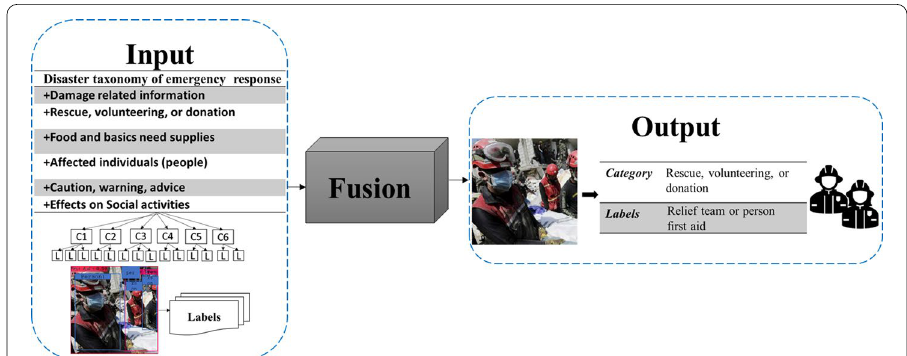
Fig. 3 Information fusion for images categorization on the proposed